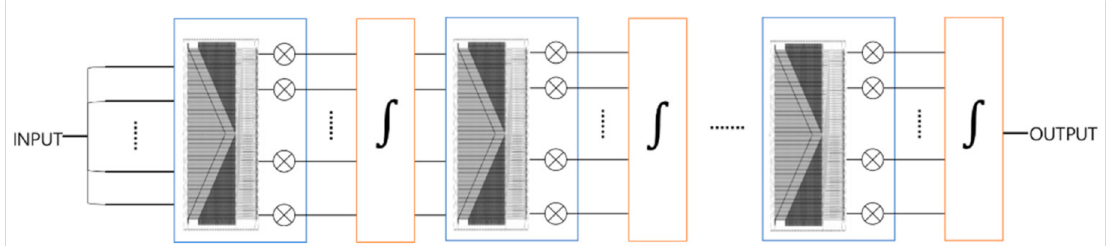
Figure 3. Schematic diagram of the optoelectronic